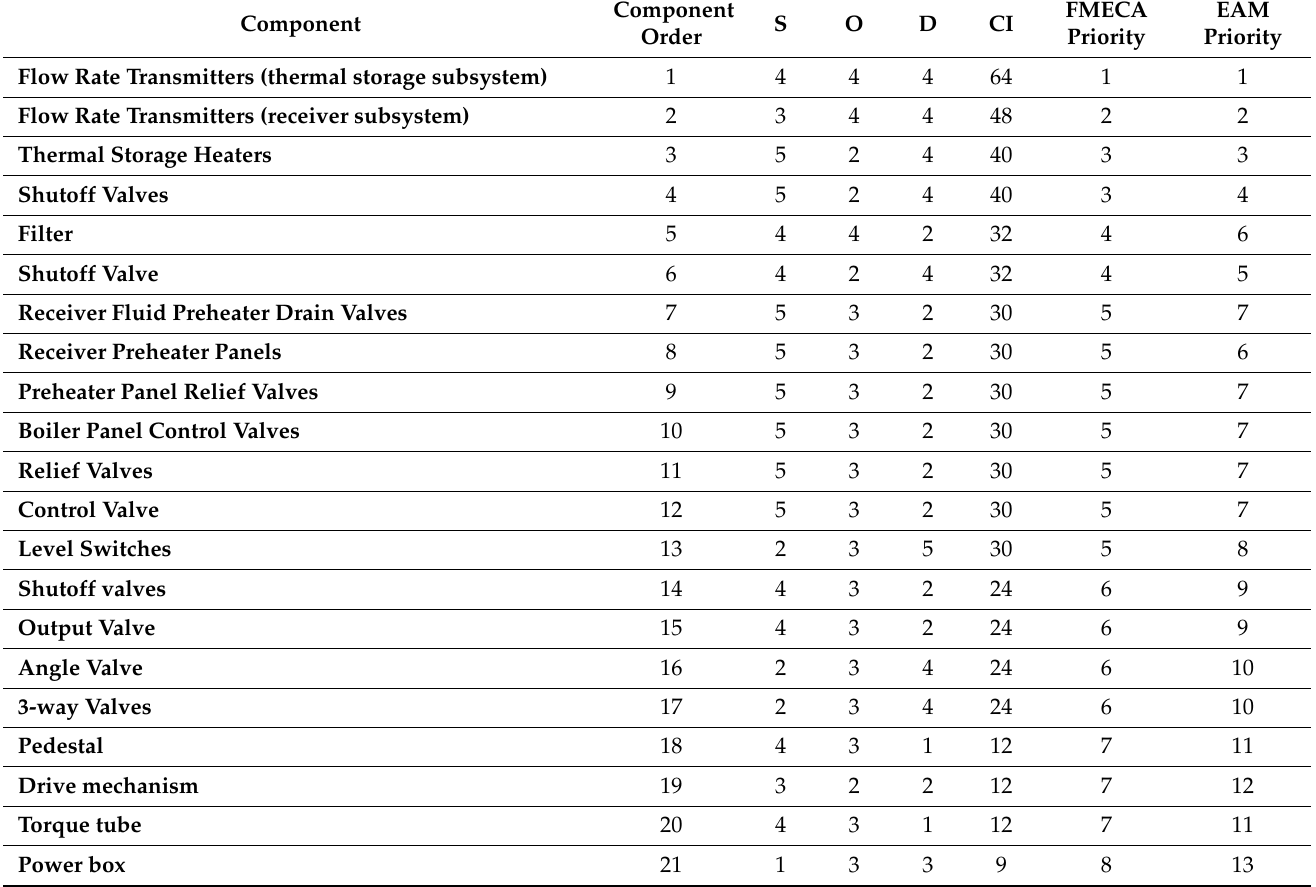
Table 7 represents the new prioritization of the different STPP components using EAM. Table 7. EAM